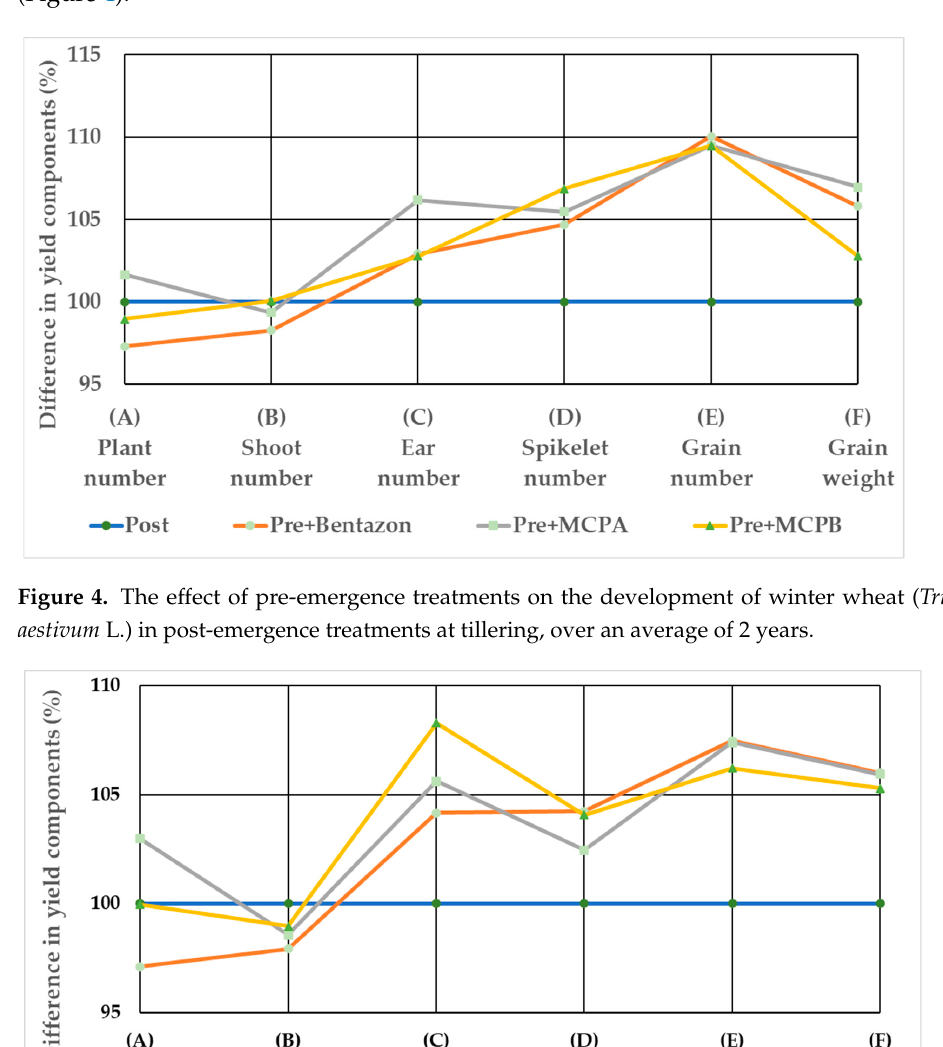
Figure 3. Development line of pure winter pea ( Pisum sativum L.) and associated winter pea ( Pisum sativum L.) over an average of 2 years.